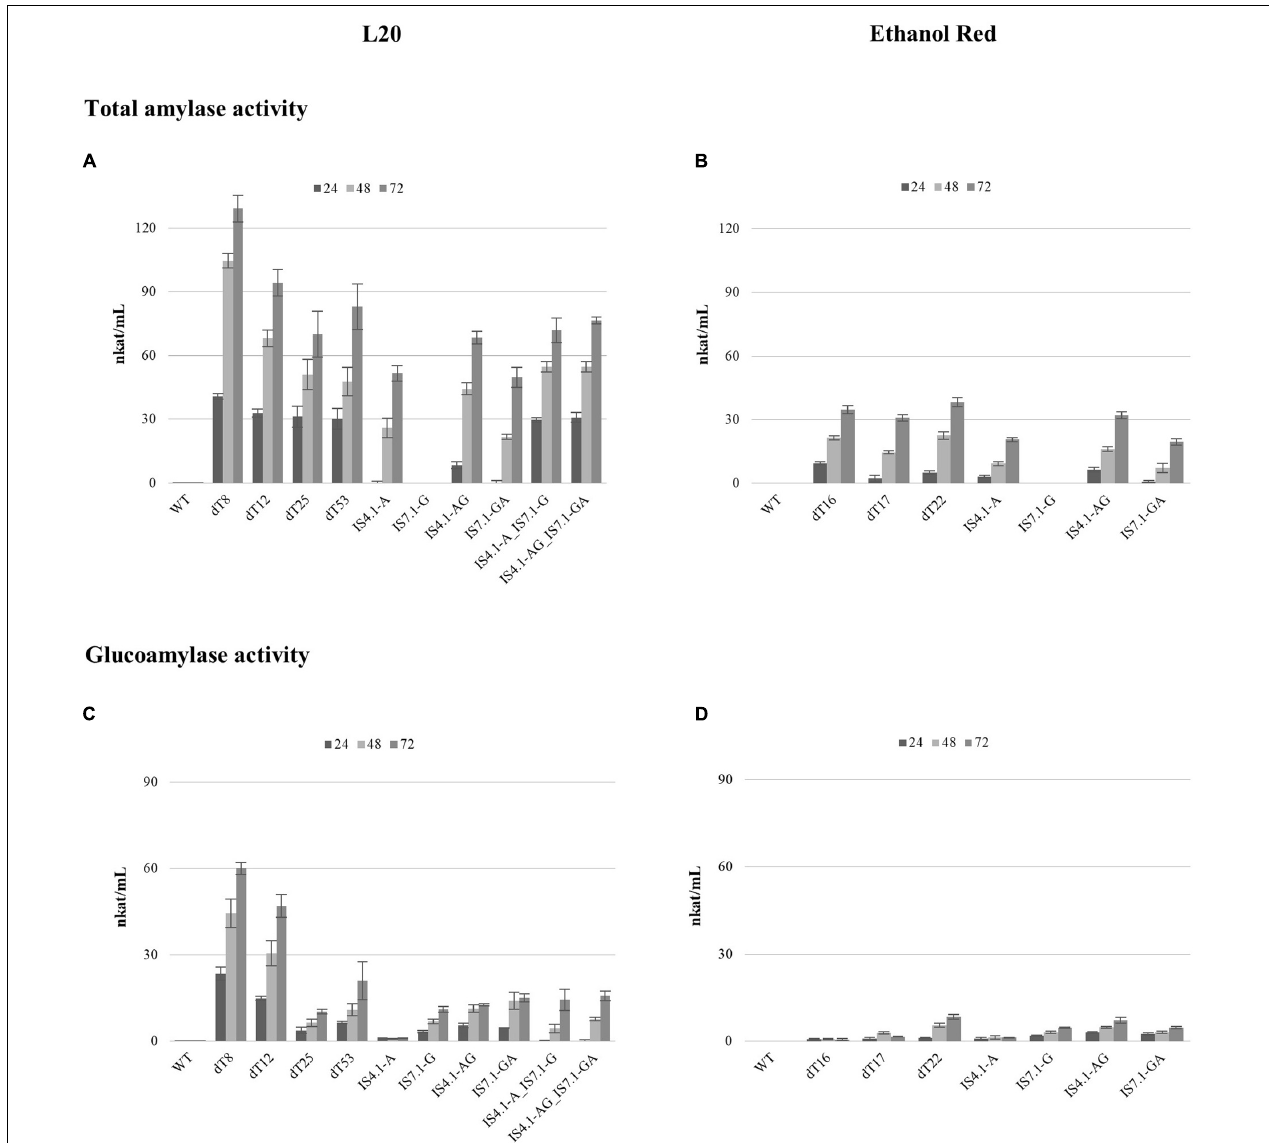
FIGURE 5 | The total amylase (A,B) and glucoamylase (C,D) activity displayed by the S. cerevisiae L20 and Ethanol Red strains expressing amyA and/or glaA genes from A. tubingensis . WT indicates the parental strain. Enzymatic activity was determined using cell-free supernatant from cultures after 24, 48, and 72 h of incubation in YPD broth. Error bars represent the standard deviation from the mean of three